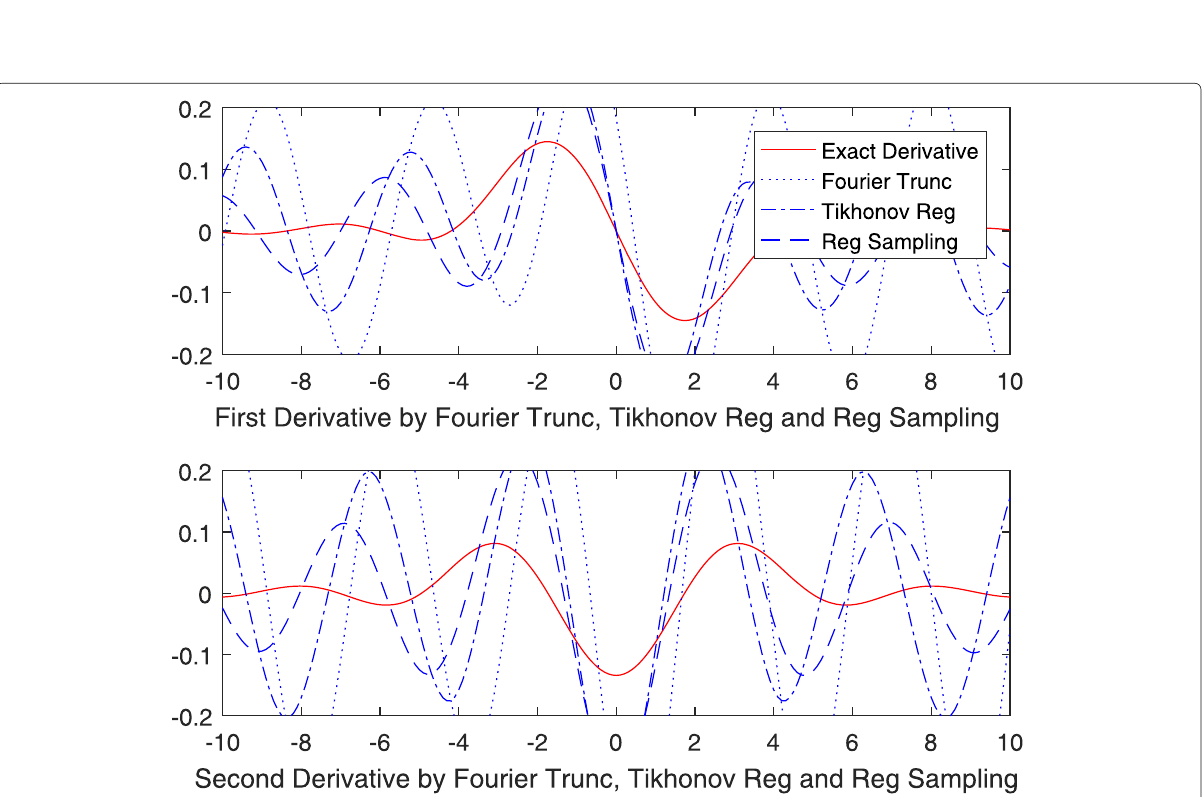
Fig. 6 The simulation results for the Gaussian noise in Example